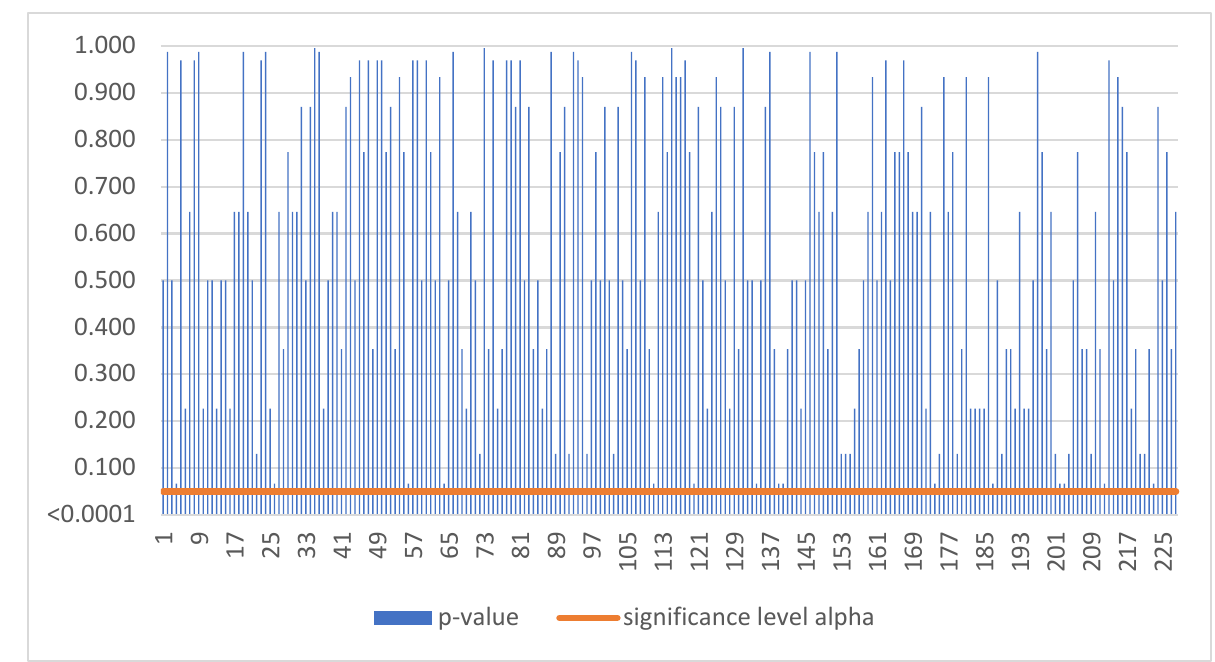
Figure 4. No trend in Czechia.